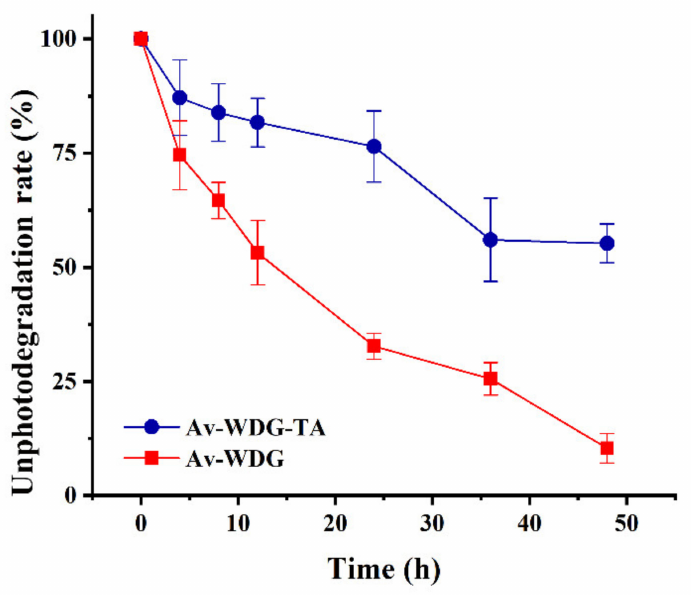
Figure 4. Photodegradation data for the Av-WDG and